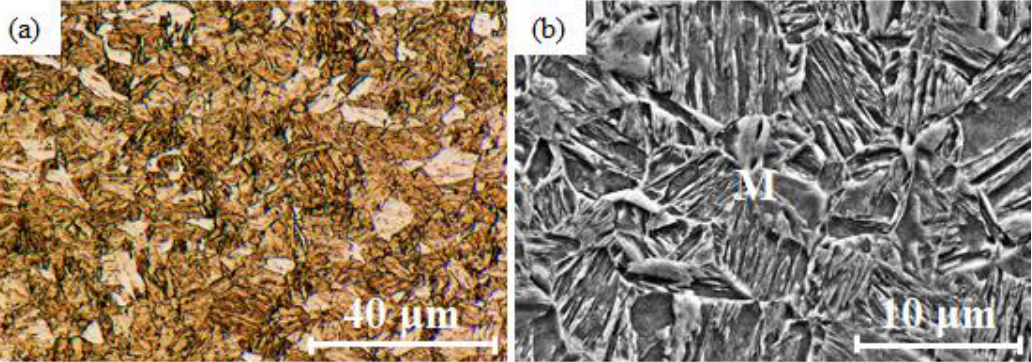
Figure 3. ( a ) LOM and ( b ) SEM images from the as-received microstructure of Ductibor ® 1000-AS (F: ferrite and M: martensite).